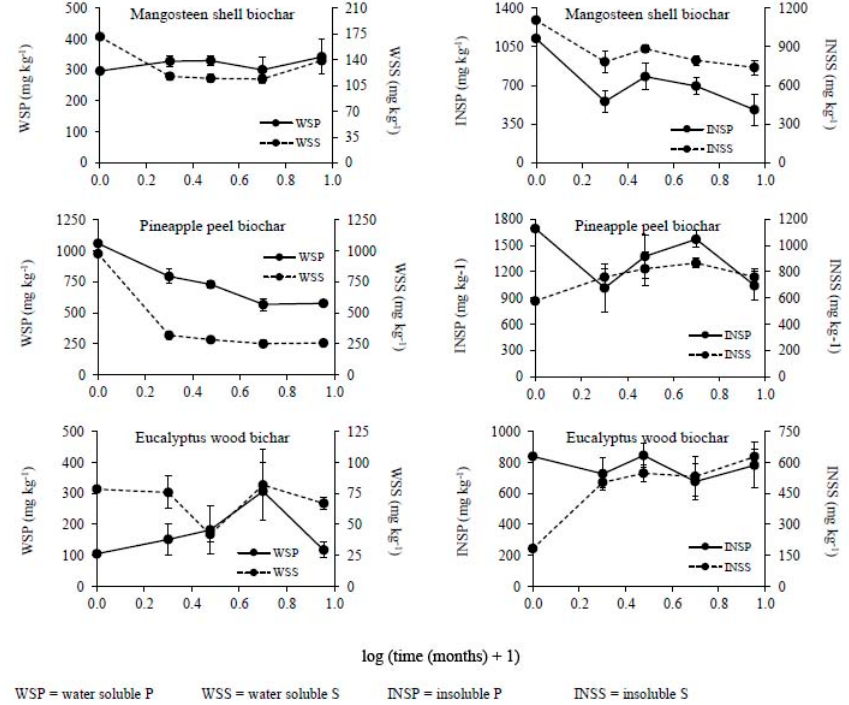
Figure 4. Plots of mean value and standard deviation for water soluble and insoluble P and S versus time in soil for three biochars recovered from soil at zero, 1, 2, 4, and 8 months. Mean values and SD are for nine soils.